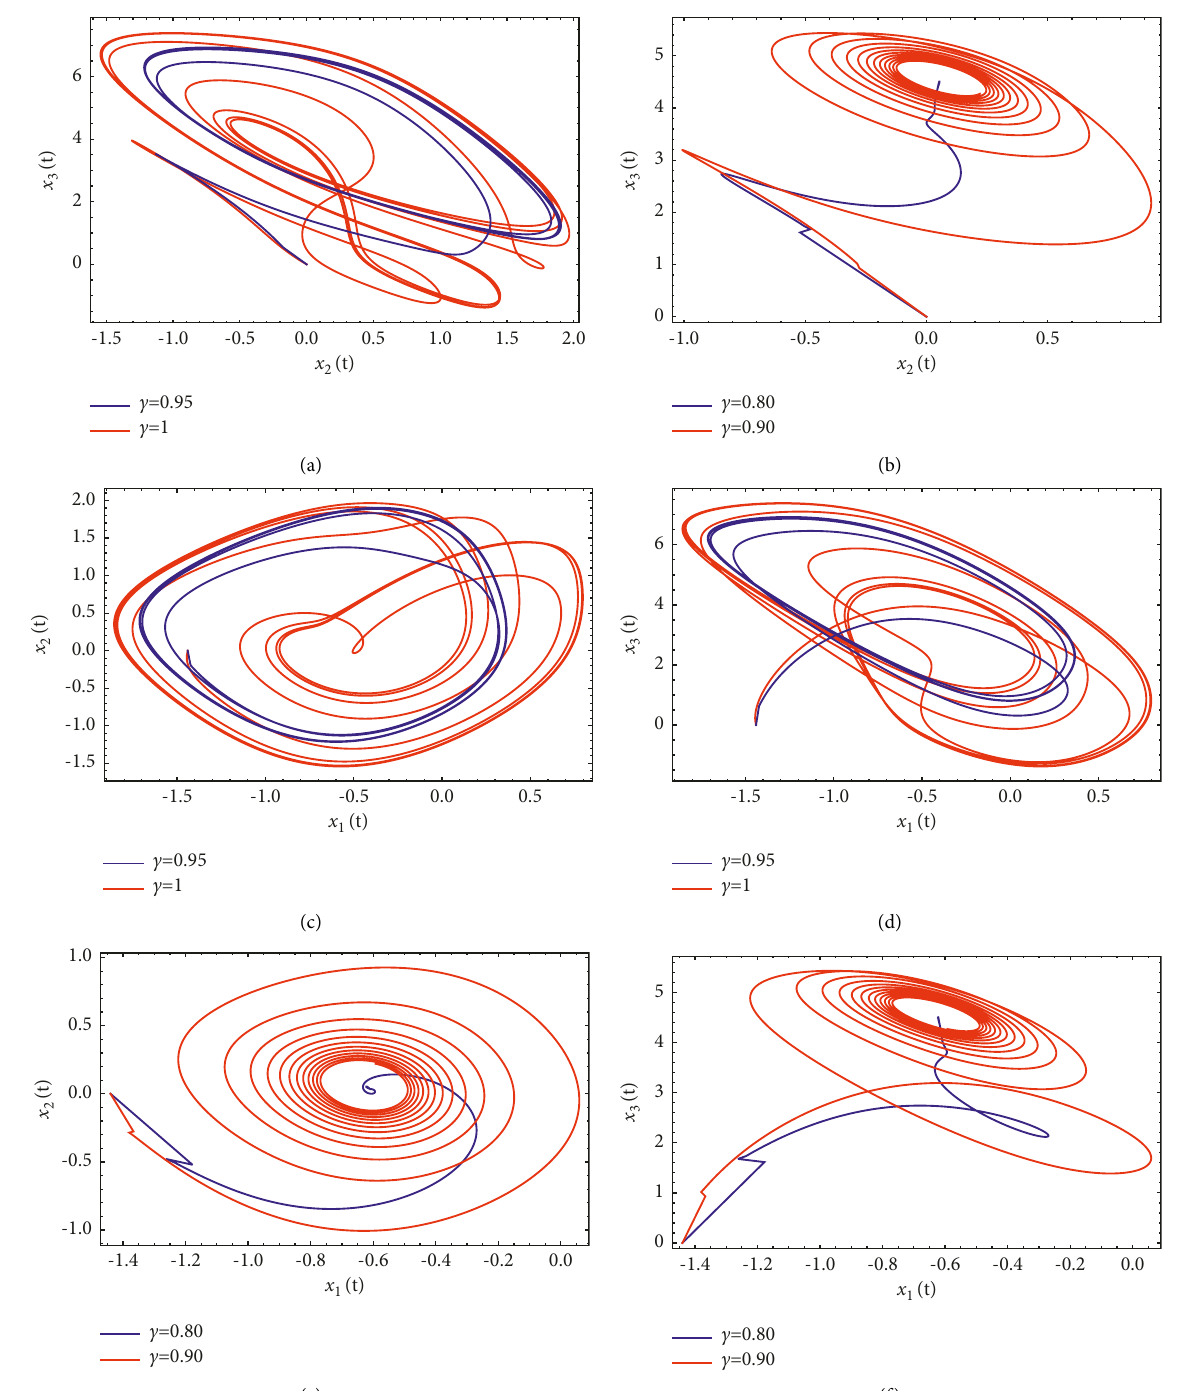
Figure 6: Dynamics of coexisting multiple attractors’ for gradient β orders. (a) State variables x 2 versus x 3 ; (b) state variables x 2 versus x 3 ; (c) state variables x 1 versus x 2 ; (d) state variables x 1 versus x 3 ; (e) state variables x 1 versus x 2 ; (f) state variables x 1 versus x 3